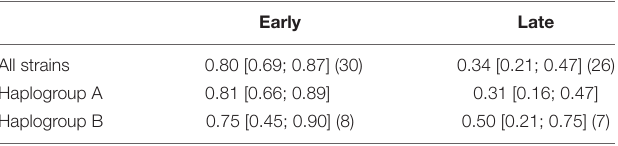
TABLE 3 | Broad-sense heritability of resistance of Paramecium caudatum to Holospora undulata , for all strains combined and for strains from haplogroups A and B,